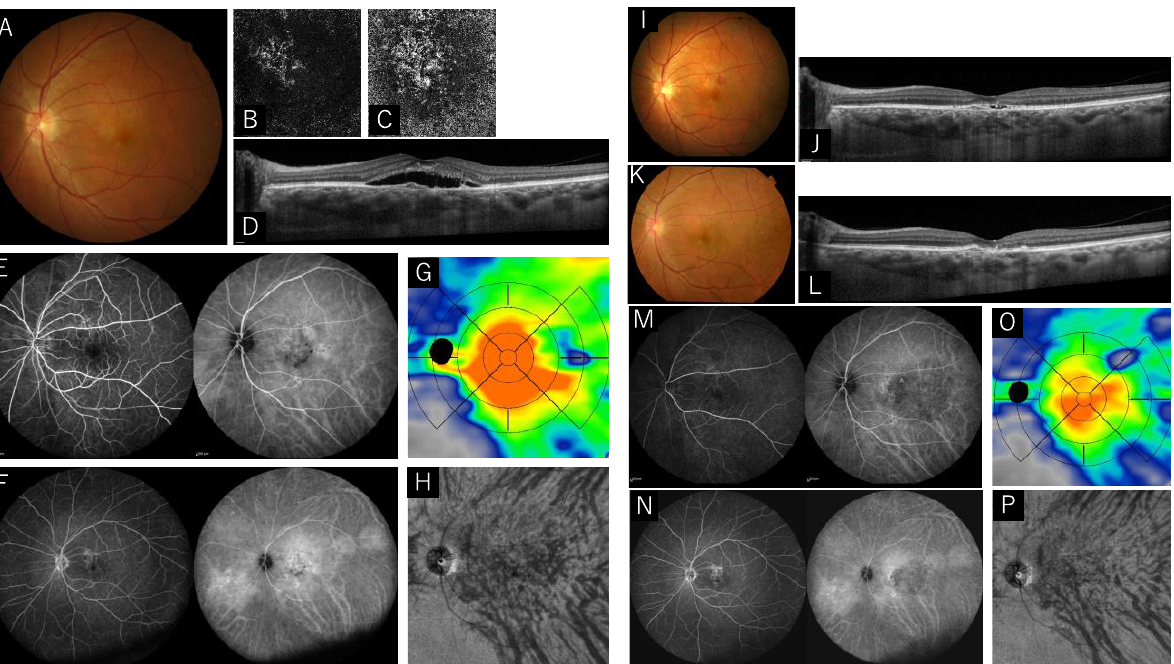
Figure 4. Images of the left eye of a 72-year-old male with pachychoroid neovasculopathy. ( A – H ) Images before treatment, ( I , J ) five months after combination therapy, and ( K – P ) one year after combination therapy. ( A ) Color fundus photograph shows the subretinal detachment in the macula. ( B , C ) Optical coherence tomography (OCT) angiography of outer retina and choriocapillaris slabs shows choroidal neovascularization. ( D ) OCT horizontal scan through central fovea shows subretinal fluid, retinal pigment epithelium undulation, and pachyvessels with inner choriocapillaris attenuation. ( E , F ) Fluorescein angiography shows diffuse leakage, and indocyanine green angiography (ICGA) shows multiple hyperfluorescein spots and wide multiple choroidal vascular hyperpermeability. ( G ) Choroidal thickness map shows thickened/thicker choroidal thickness, especially in the central area. ( H ) En face OCT image in the deep layer of the choroid shows dilated choroidal vessels, and horizontal watershed zone cannot be observed/or is unclear. ( I , J ) Five months after combination therapy, retinal hemorrhage was observed and shallow subretinal fluid appeared. ( K , L ) One year after combination therapy, orange-red raised lesion was observed in superior macula, with no exudative changes. ( M , N ) ICGA shows dark spot in macula and new polyps, and the condition was diagnosed as polypoidal choroidal vasculopathy. ( O ) Choroidal thickness map shows reduction in choroidal thickness in the central area. ( P ) En face OCT image shows constriction of choroidal blood vessels.